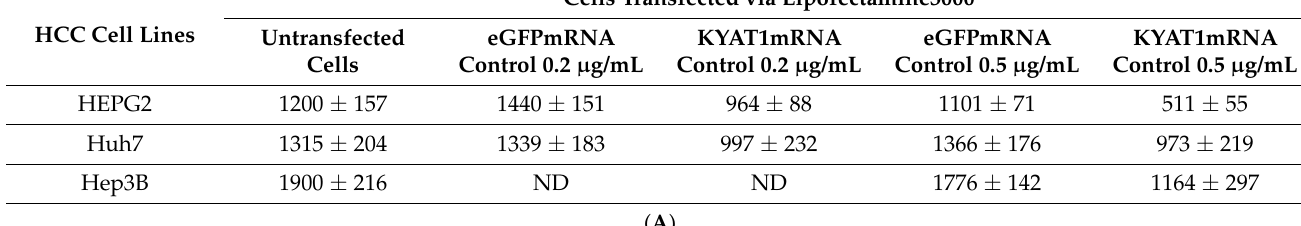
Table 1. ( A ). Relative IC 50 values of MSC at 72 h in HEPG2, Huh7 and Hep3B cells transfected with 0.2 µ g/mL and 0.5 µ g/mL of eGFPmRNA- or KYAT1mRNA using lipofectamine 3000. Results are presented as mean ± SD from triplicate measurements from at least five independent experiments. Resultant IC 50 values are denoted in µ M. ND = not determined. ( B ). Relative IC 50 values of MSC at 72 h in HEPG2, Huh7, and Hep3B cells transfected with 0.2 µ g/mL and 0.5 µ g/mL of LNP encapsulated eGFPmRNA- or KYAT1mRNA. Results are presented as mean ± SD from triplicate measurements from at least five independent experiments. Resultant IC 50 values are denoted in µ